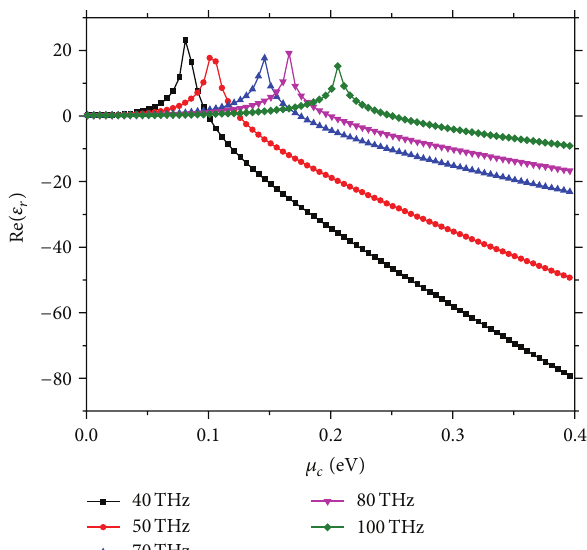
Figure 1: Relation between chemical potential and real part of graphene’s equivalent dielectric permittivity at different frequencies with 𝑇 = 3 K and Γ = 0.43 meV.